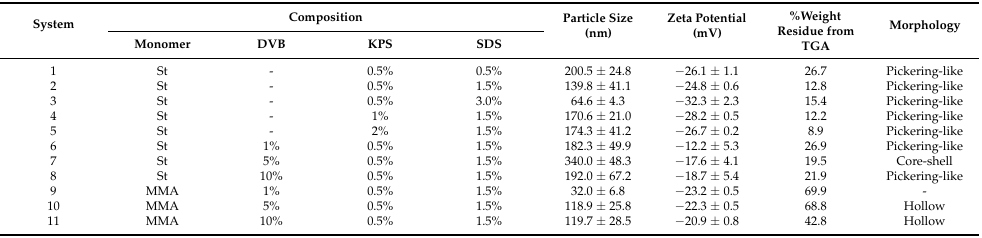
Table 1. Formula of ZPPs with relevant characteristics, i.e., average particle size from TEM, zeta potential, and %weight residue from